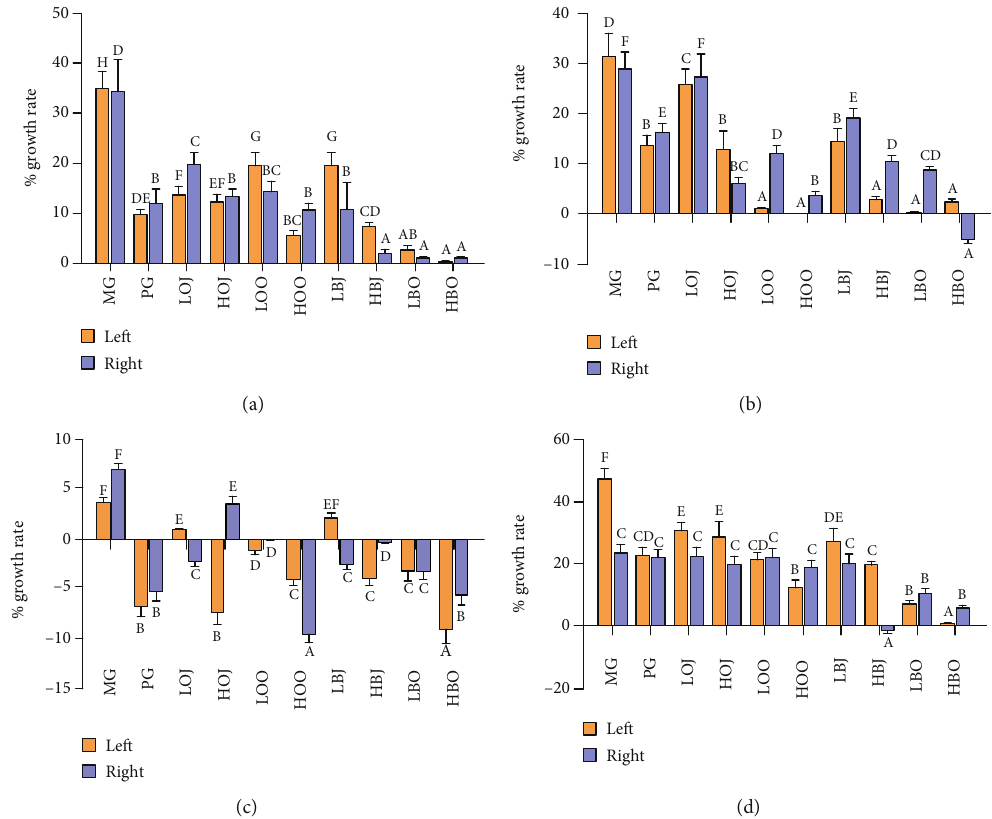
Figure 1: E ff ect of di ff erent treatments on the growth rate of sebaceous gland spots: (a) the growth rate of sebaceous gland spots in the fi rst week, (b) the growth rate of sebaceous gland spots in the second week, (c) the growth rate of sebaceous gland spots in the third week, and (d) the growth rate of sebaceous gland spots in the fourth week. Values are expressed as the mean ± SD ( n = 8 ). Data with di ff erent letters indicate signi fi cant di ff erences ( P < 0 : 05